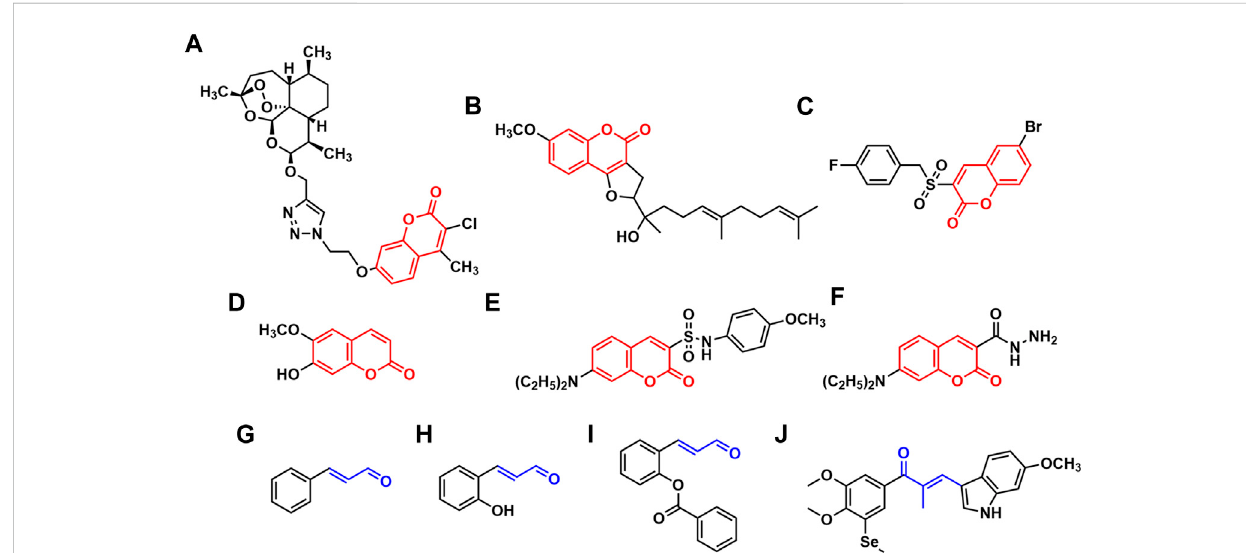
FIGURE 1 The reported coumarin derivatives (A – F) and the derivatives containing acrolein moiety (G – J)